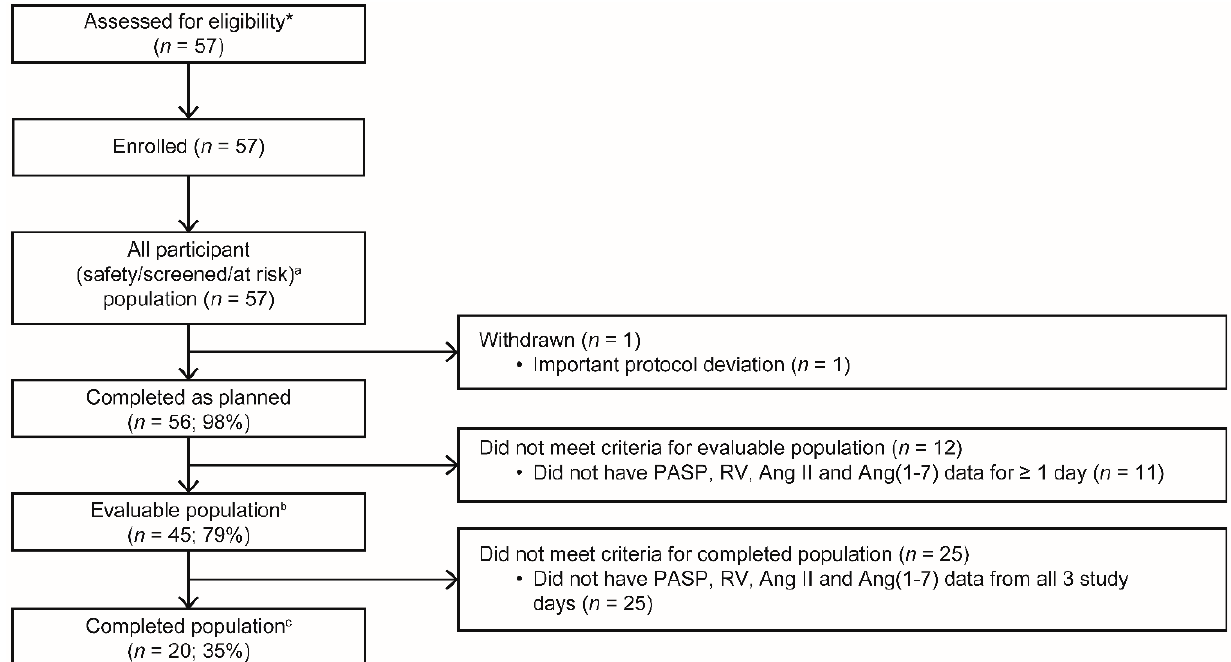
Figure 2. Participant flow. * Patients were pre-screened for eligibility; however, the number of pre-screened patients is unavailable. a Screened population: all participants who were screened. Safety population: all participants for whom at least one echocardiograph and/or blood sample was taken. At-risk population: participants for whom PASP and RV size ratio were recorded for all three study days and/or had a databased PCD and/or ARDS assessment during the study period. b Evaluable population: all participants for whom PASP , RV size ratio, Ang II, and Ang(1–7) data were recorded for at least one study time point. c Completed population: all participants for whom PASP , RV size ratio, Ang II, and Ang(1–7) data were recorded for all three study days. ACP , acute cor pulmonale; Ang , angiotensin; ARDS , acute respiratory distress syndrome; PASP , pulmonary arterial systolic pressure; PCD , pulmonary circulatory dysfunction; RV , right ventricle. Table 1. Participant demographics and clinical characteristics at inclusion.